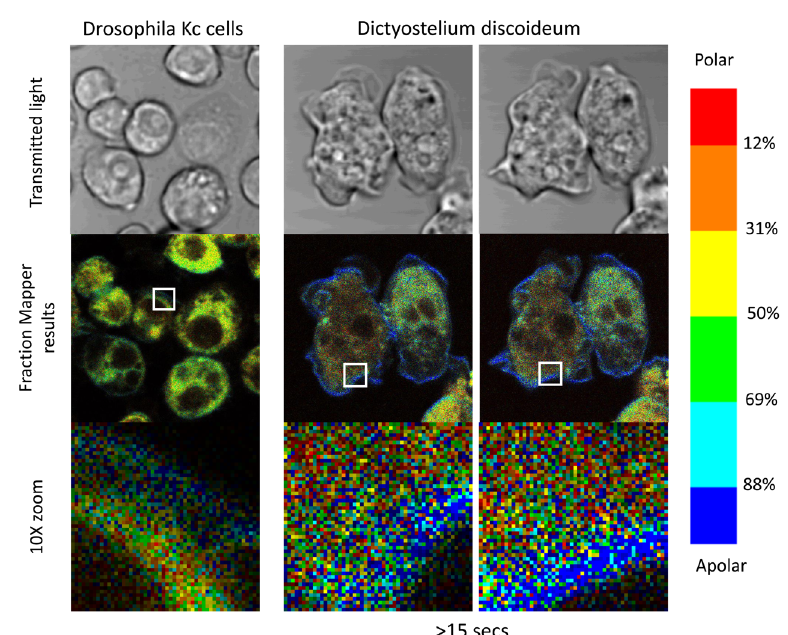
Figure 14. Staining of Drosophila and Dictyostelium cells. Right column: KC cells from Drosophila melanogaster were grown for 48 hours on PLL-coated coverslips in a 6-well plate before transfer to an observation chamber and staining with 400 nM of C-laurdan in serum-free medium. Middle and right columns: Dictyostelium discoideum amoebae (AX2 strain) were transferred directly to an observation chamber with a glass coverslip bottom for a couple of hours in axenic medium before staining with 800 nM C-laurdan in Sörensen’s buffer. The pictures in the right column, taken 15 seconds after those in the middle column, show that the motility of the amoebae triggered by the stimulation by light of these photo-reactive cells is not accompanied by any noticeable modification in the overall state of their lipid membranes. All pictures were taken at zoom 6: whole picture 35×35 µM, pixel size : 69 nm Droso: Tests 20 Oct 2016 Droso KC (Z6 3) Dictyo :Tests 25 Oct 2016 : AX2